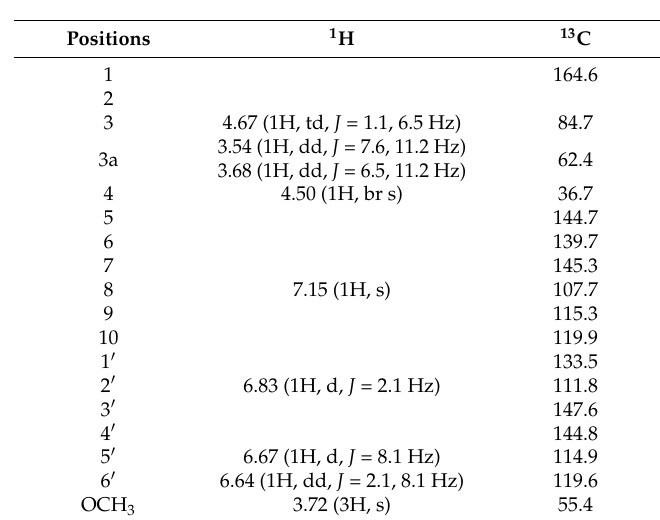
Table 2. 1 H - NMR (500 MHz) and 13 C-NMR (125 MHz) data of compound 3 in DMSO- d 6 .